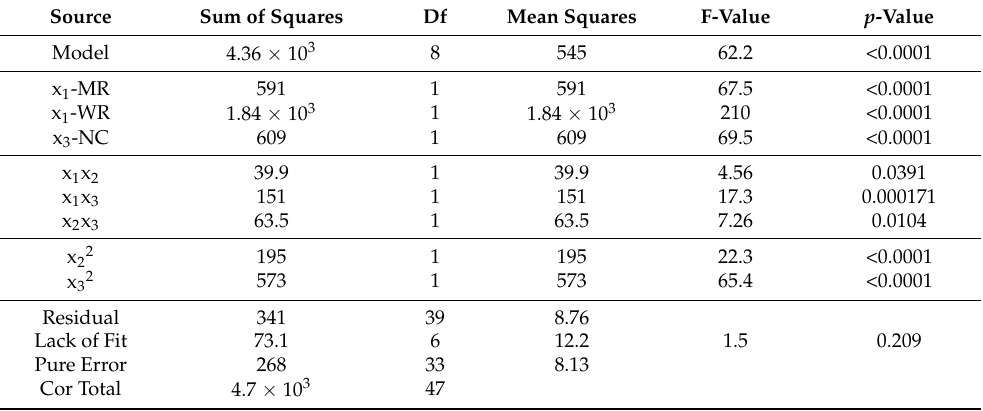
Table 4. Response model and statistical parameters obtained from ANOVA for central composite